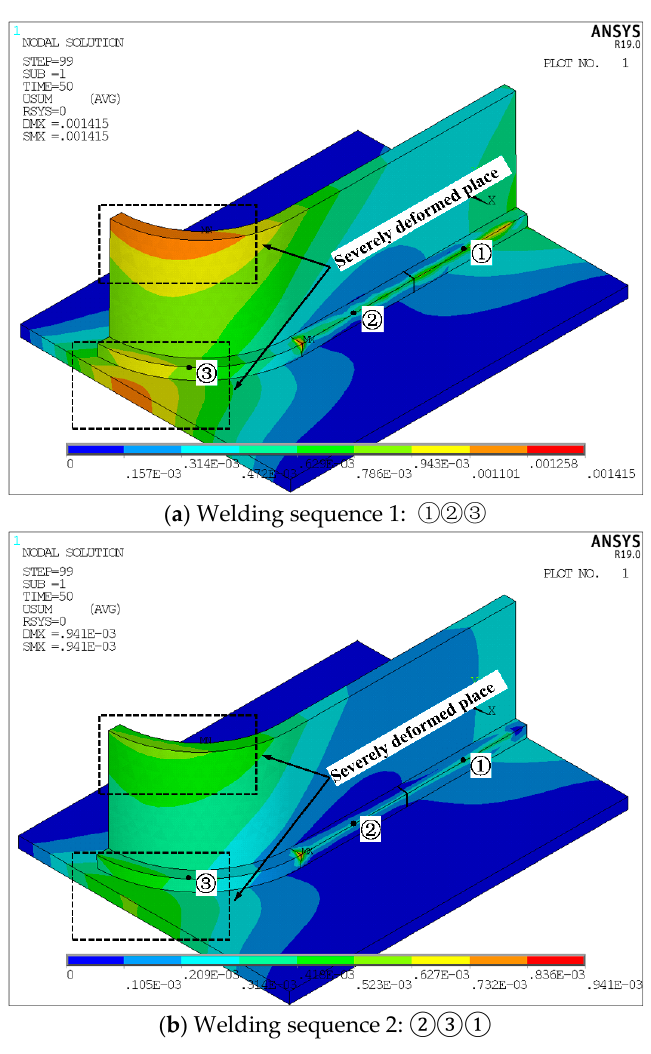
Figure 4. Deformation cloud map of the welded part under two welding sequences.